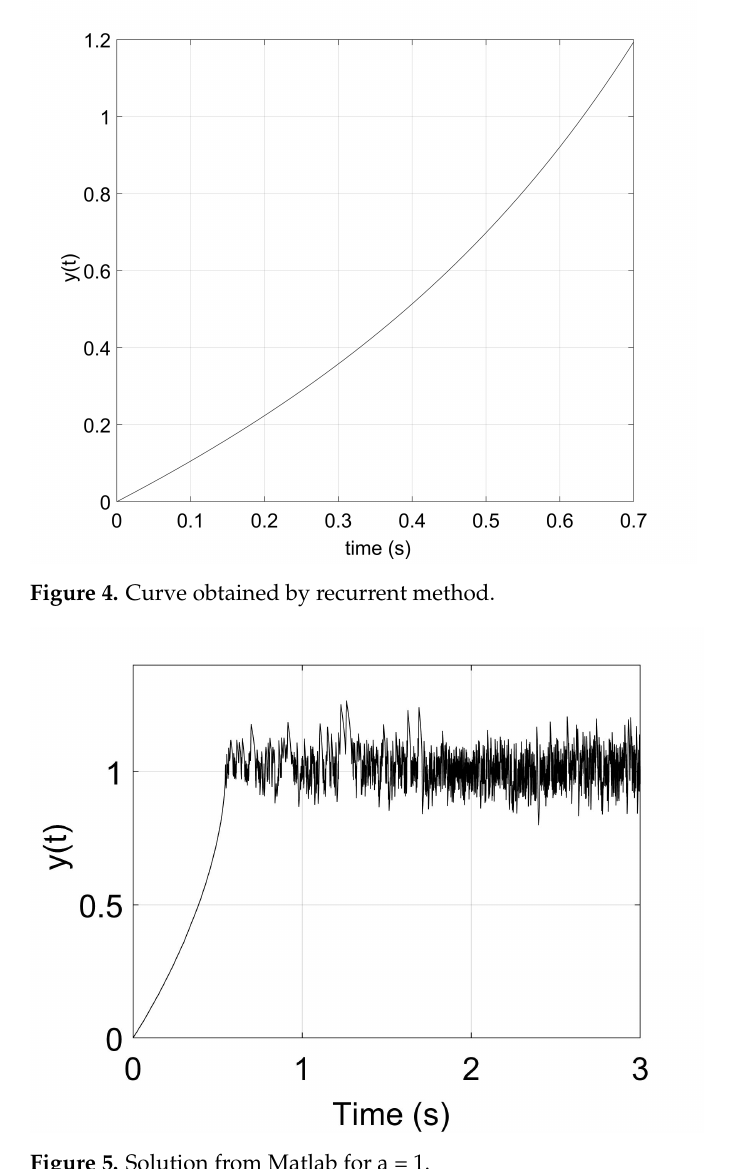
Figure 5. Solution from Matlab for a = 1.